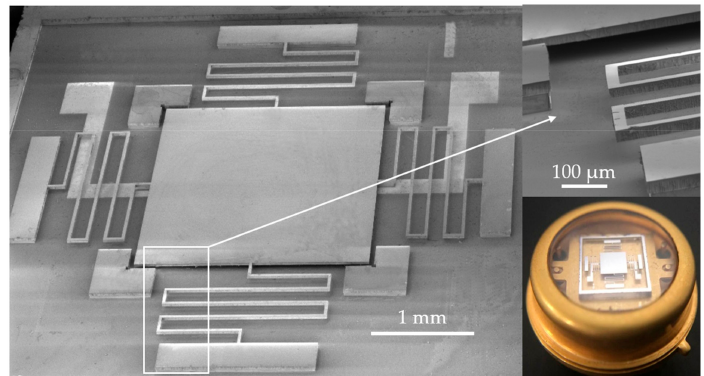
Figure 4. SEM (scanning electron microscope) and optical photographs of the fabricated and packaged micro-switches.